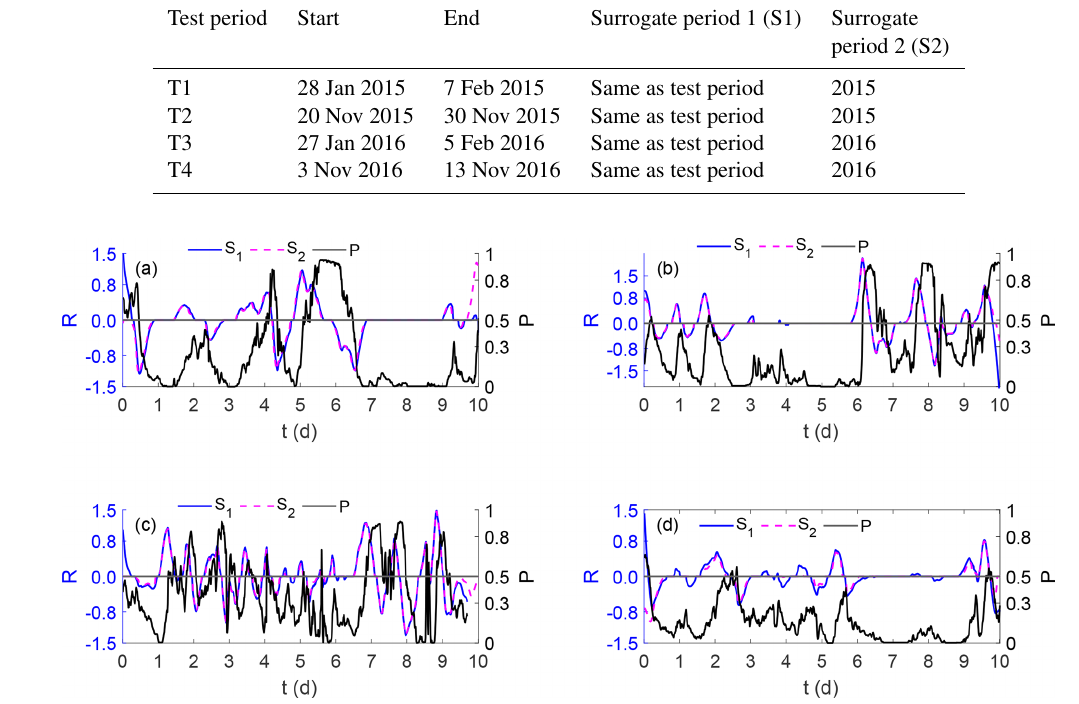
Figure 6. Normalised power ramps: (a) period T1, (b) period T2, (c) period T3, and (d) period T4. Normalised wind power is shown in black. The ramp-ups and ramp-downs derived using surrogate statistics from the 10d period (S1) are shown in blue; and those from the 1-year period (S2) are shown in